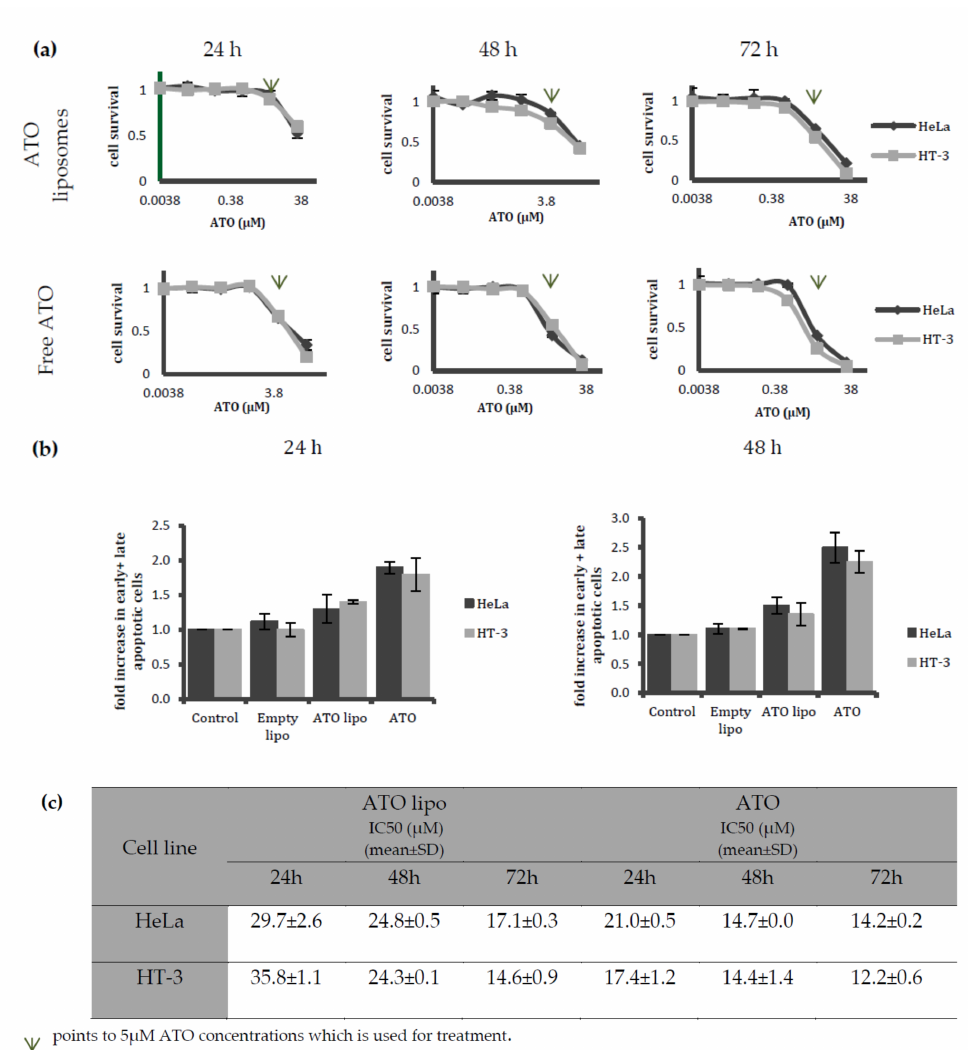
Figure 4. The MTT assay and flow cytometry analysis to compare cellular toxicity and apoptosis induction of varying treatments on HeLa and HT-3 cells. ( a ) Cell viability of HeLa and HT-3 cell lines following incubation with liposomal encapsulated ATO (ATO lipo) and free ATO for 24, 48 and 72 h; ( b ) Flow cytometry analysis of apoptotic populations that were treated with complete media as control, empty liposomes, liposomal 5 µ M ATO, or 5 µ M free ATO on HeLa and HT-3 cell lines following treatment for 24 and 48 h; ( c ) Calculated IC 50 values for ATO lipo and free ATO treated HeLa and HT-3 cells after 24, 48, and 72 h. Data are presented as mean ± SD of three replicate